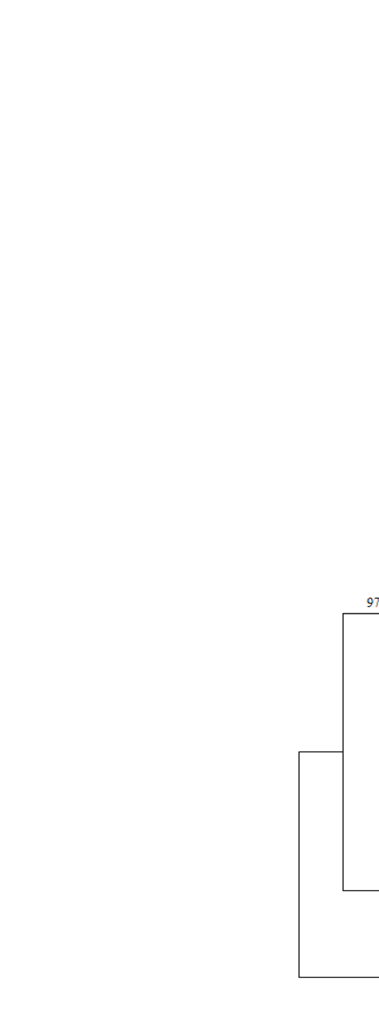
FIGURE 2 A phylogenetic tree of proteins similar to ZIP from A. thaliana , O. sativa and T. cacao , built using MEGA11 software by the NJ method, with 1000 bootstrap replicates. The beginning of each gene ID contains the code for the species as Tc, T. cacao ; At, A. thaliana and Os, O. sativa . The groups are distinguished by different